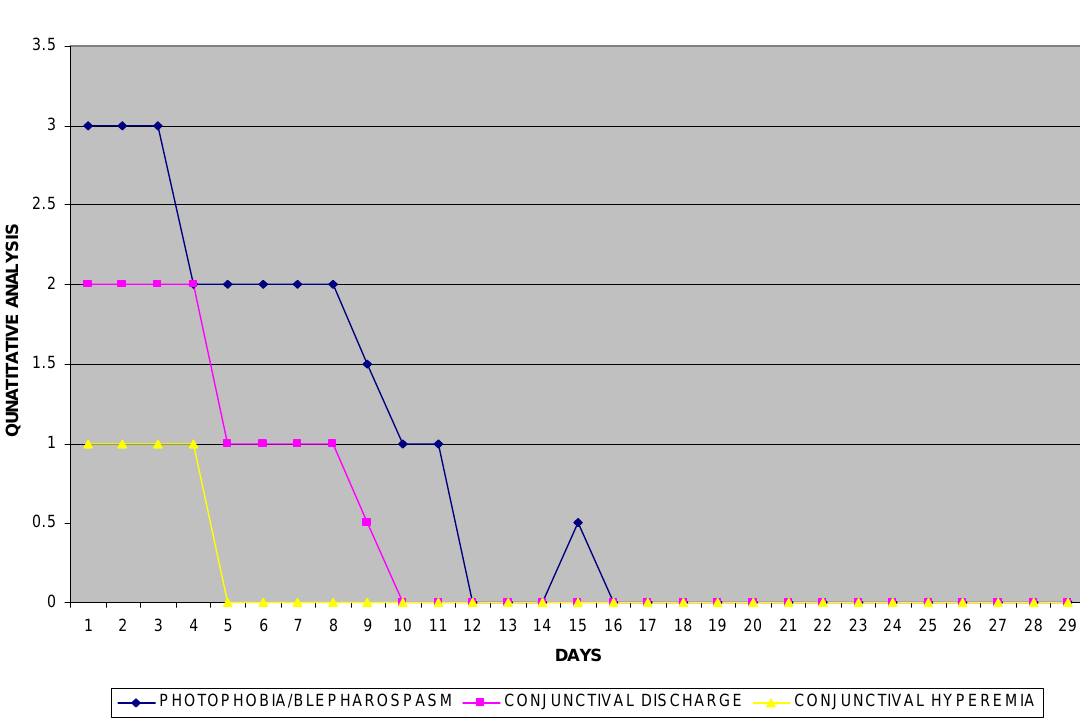
Figure 7. Graphic representation of the clinical evolution of corneas treated with keratoplasty using fibrin